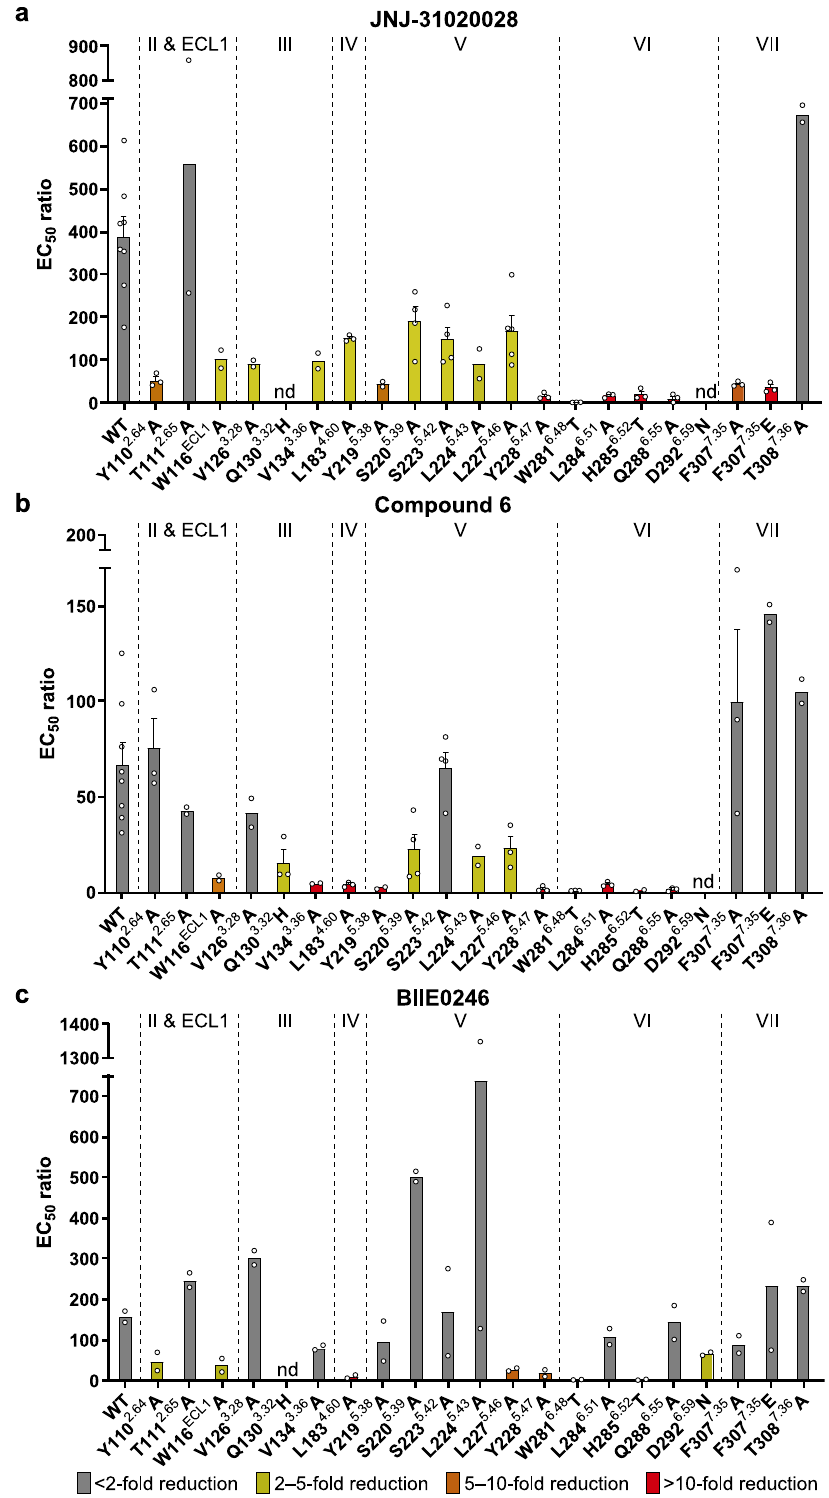
antagonistic activity, which would facilitate future drug